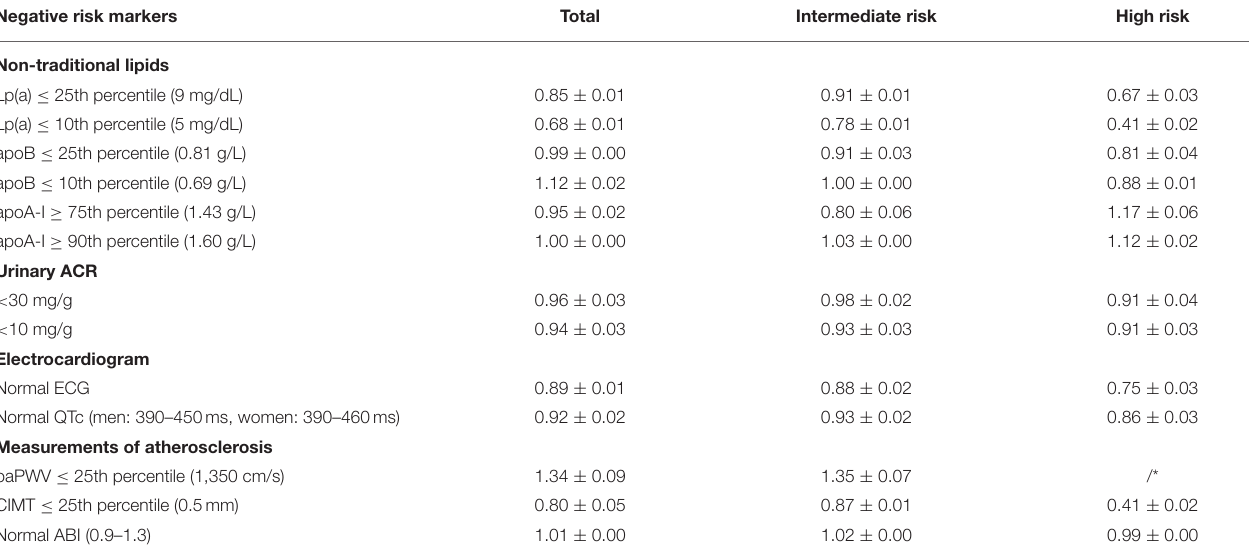
TABLE 5 | Multivariable adjusted